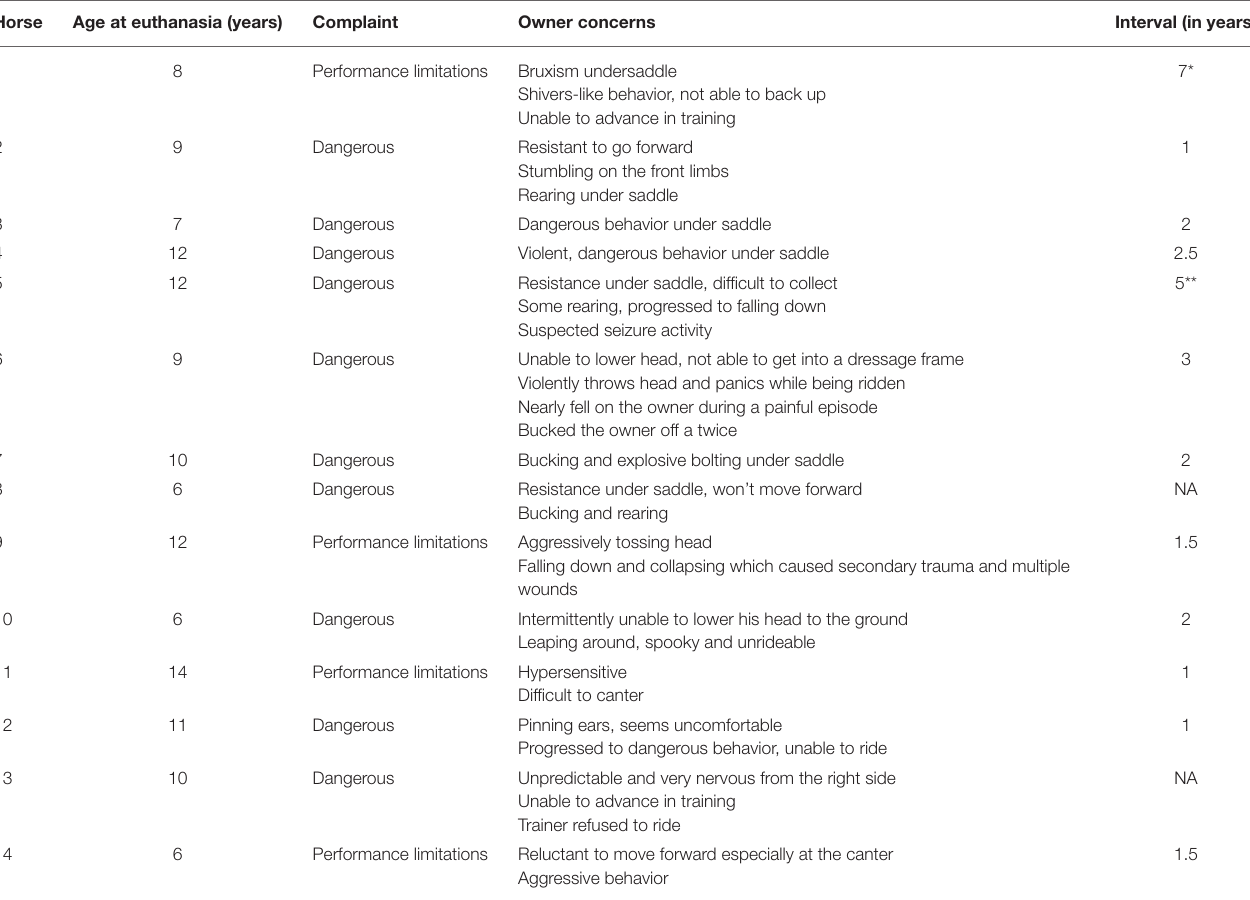
TABLE 1 | Presenting owner complaint and the interval of time from purchase to euthanasia. Horse Age at euthanasia